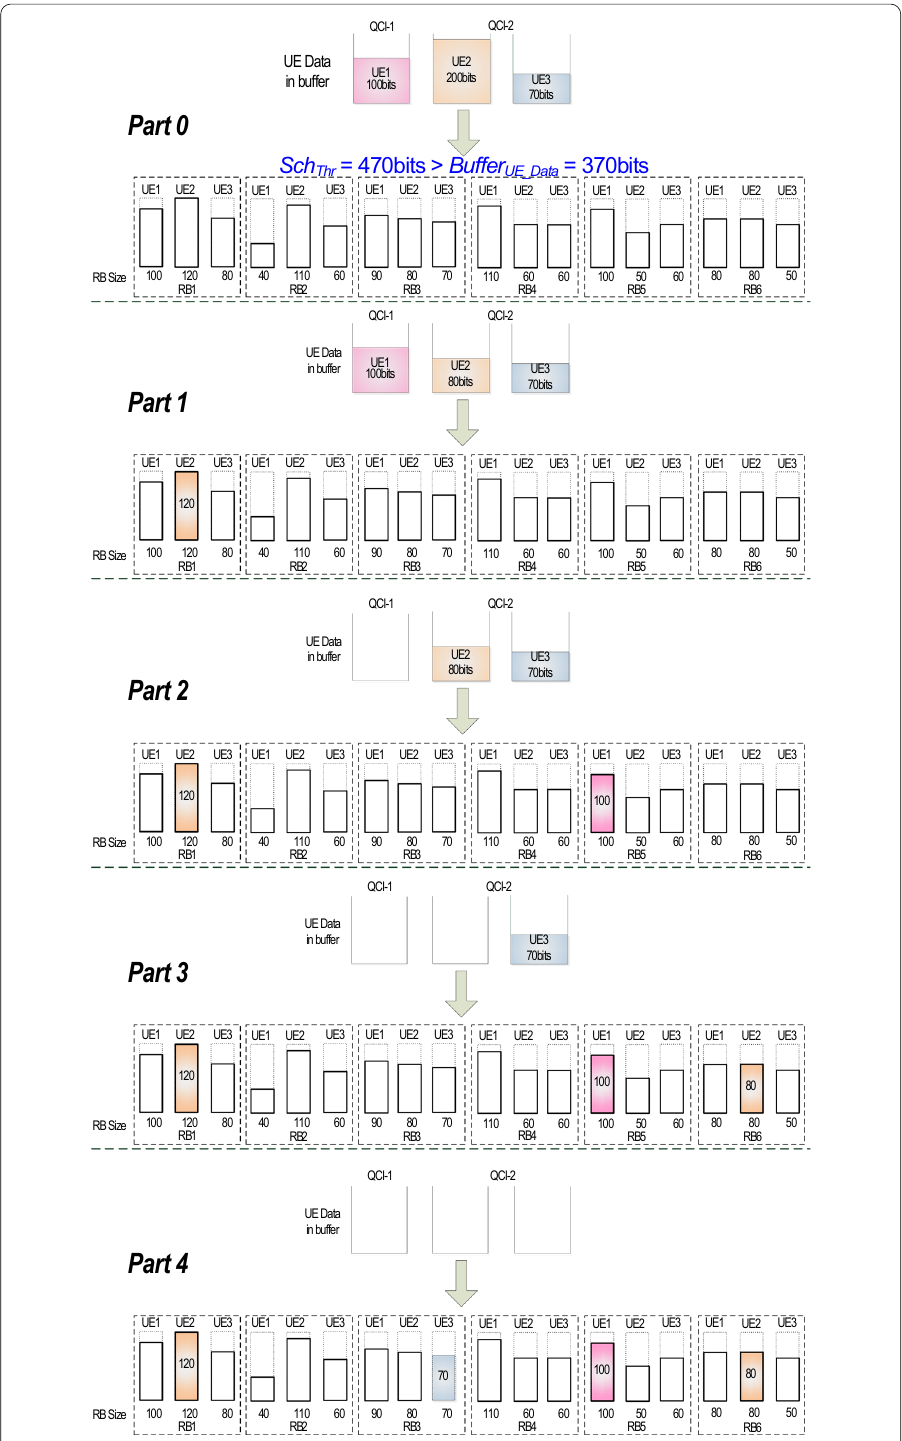
Fig. 6 Example of proposed EURA resource allocation scheme; Example case of our proposed EURA resource allocation